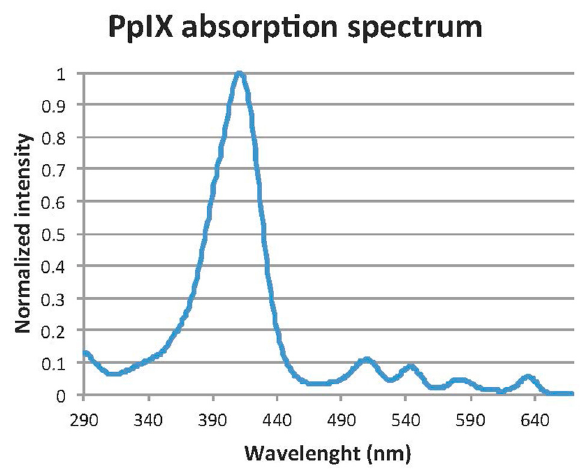
Figure 1. Photobleach protoporphyrin IX (PpIX) absorption spectrum. Reproduced with permission from Stine R. Wiegell, British Journal of Dermatology; published by Wiley and Sons, 2009.